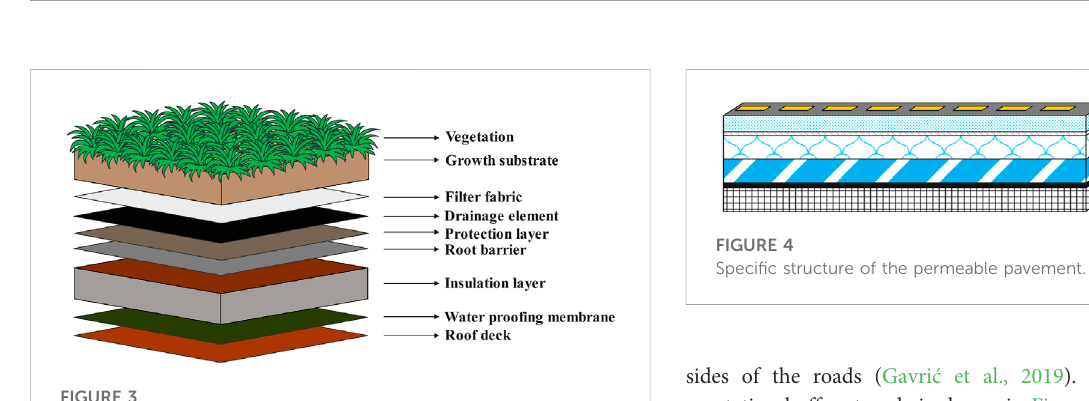
FIGURE 3 Speci fi c structure of the green roof.